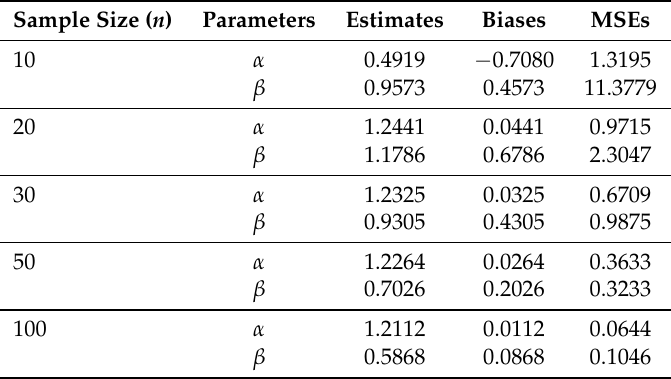
Table 6. Estimates, biases and MSEs for α = 1.2 and β =